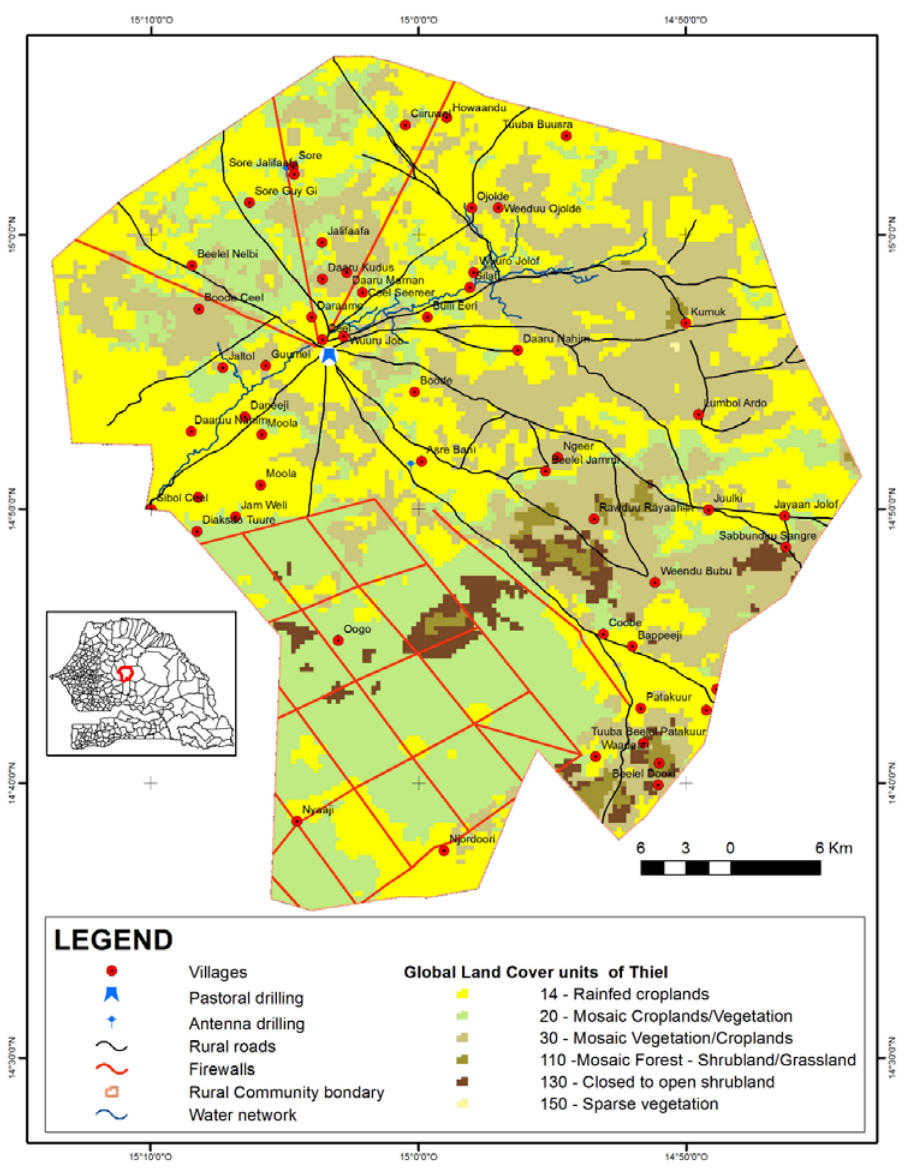
Figure 1. The agropastoral rural community of